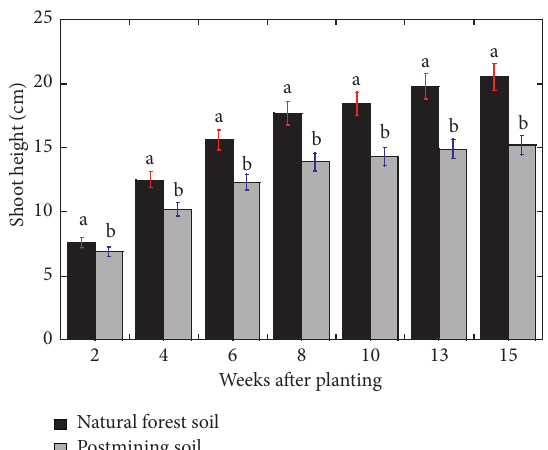
Figure 4: Mean shoot height of Albizia saman grown in soil from post-nickel mining land and natural forest for 15 weeks under greenhouse condition. Different letters indicate significant differences ( P � 0 . 05). Error bars indicate standard error ( n �